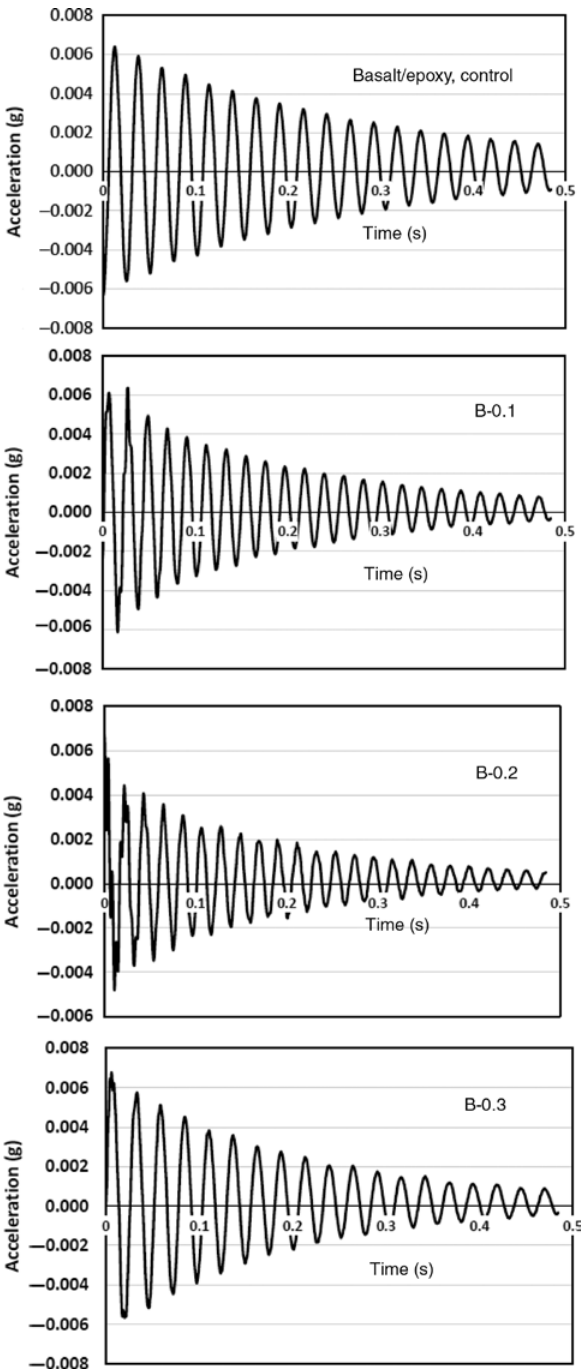
Figure 5: The free decay curves of the test samples with different GnPs loadings.